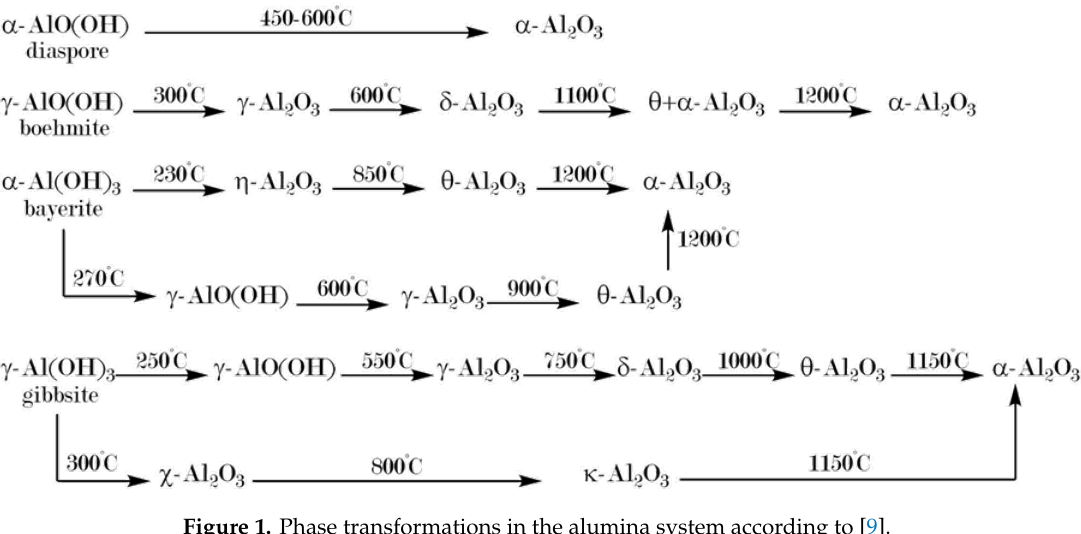
Figure 1. Phase transformations in the alumina system according to [9]. Materials 2020 , 13 , x FOR PEER REVIEW 3 of 36 Figure 1 . Phase transformations in the alumina system according to [9].